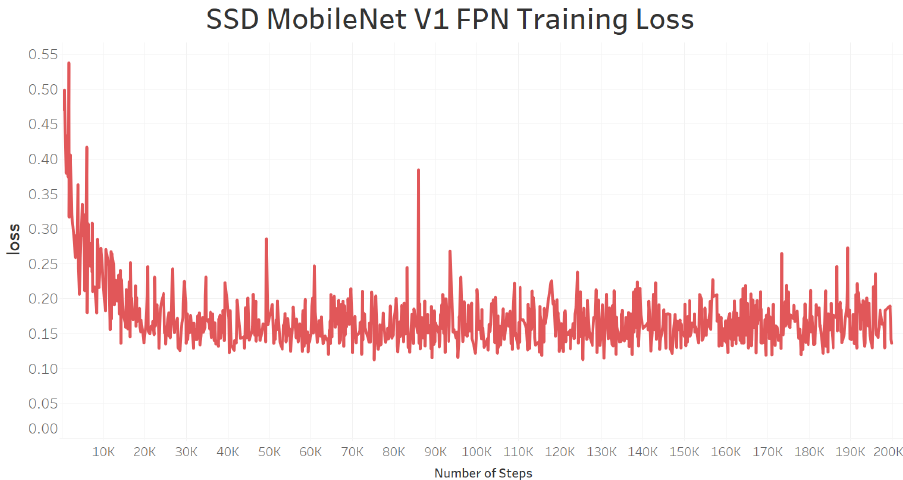
Figure 16. The SSDV1lite model has a training loss of around